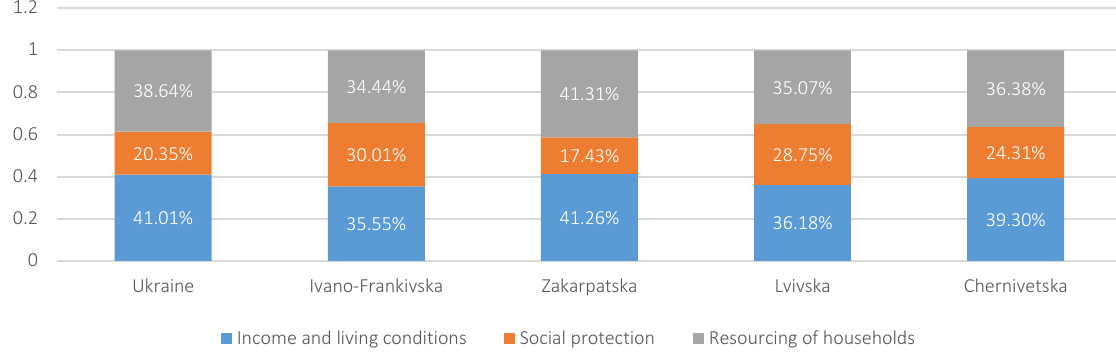
Figure 1. Priority of indicator groups in securing financial wellbeing of households: across weights, 2010–2019,